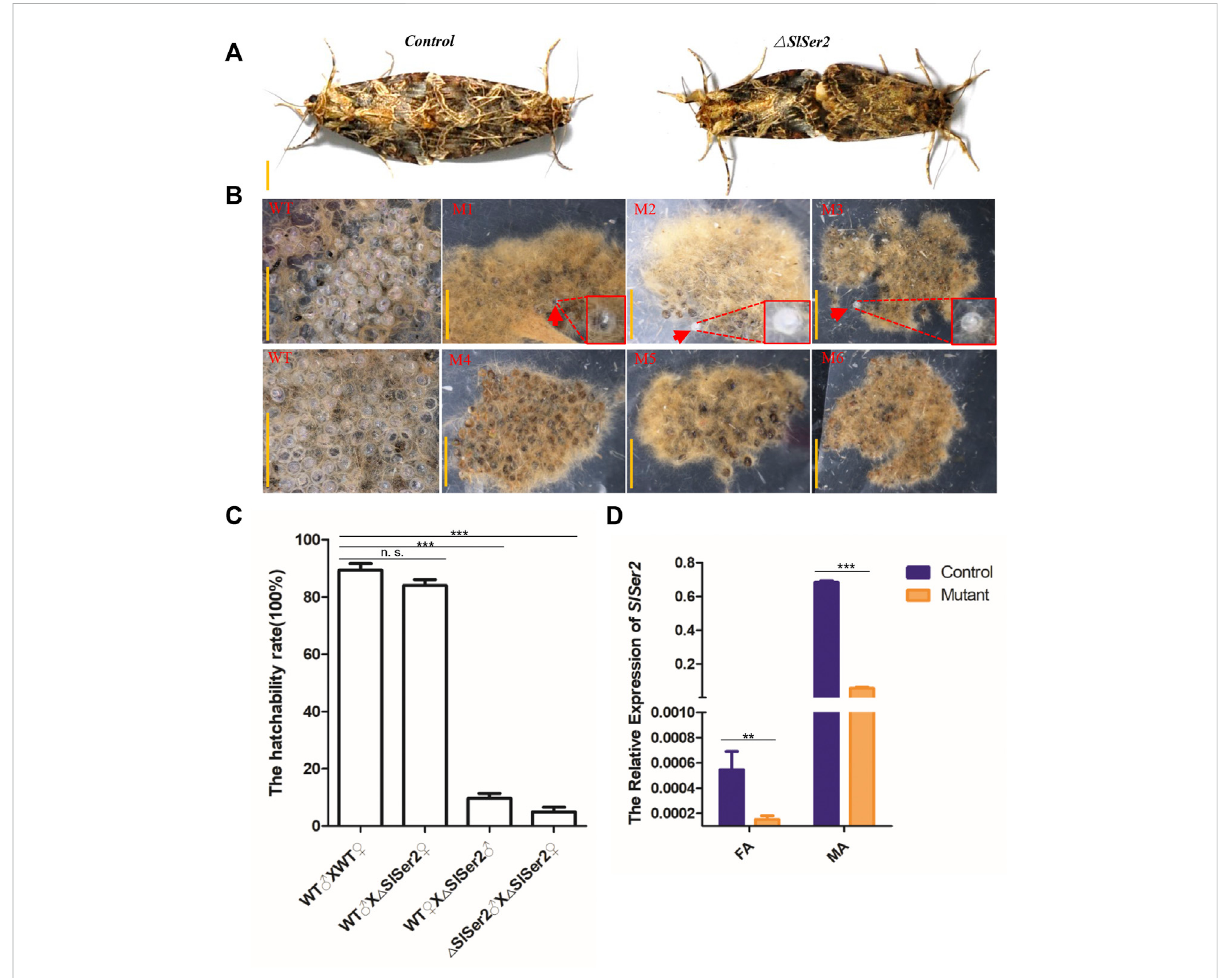
FIGURE 3 Loss of SlSer2 function results in male sterility. (A) The wild type and Ser2 mutants can mate with each other normally. Scale bar: 0.5 cm. (B) CRISPR/Cas9-mediated disruption of Ser2 induced male sterility. WT, wild type egg masses. M1-M6, Ser2 mutant egg masses. Scale bar: 2 mm. (C) The hatchability rate between wild type and mutants. (D) The relative mRNA expression of SlSer2 in wild type and Ser2 mutants. mRNA expression was normalized to SlActin . FA, female adult; MA, male adult. The data shown are means ± S.E.M. Asterisks indicate signi fi cant differences with a two-tailed t -test: * p < 0.05; ** p < 0.01; *** p < 0.001; n. s. p >